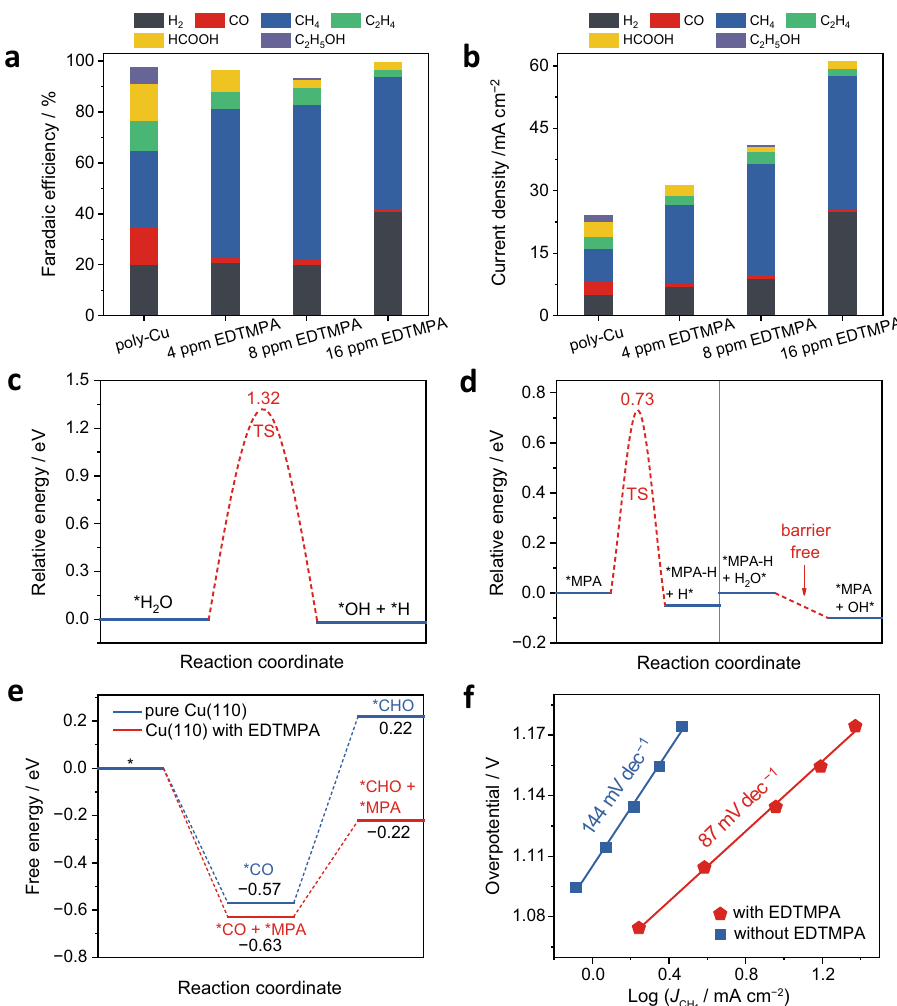
Fig. 4 Proton-feeding ability of EDTMPA. a , b Comparison of the FEs ( a ) and partial current densities ( b ) of various CO 2 RR products at − 1.0 V versus RHE in electrolytes without and with different amounts of EDTMPA (4 ppm, 8 ppm and 16 ppm). c Kinetic energy diagram of water dissociation on bare Cu(110). TS stands for the transition state. d Kinetic energy diagrams of an H atom transferred from MPA to Cu(110) and then an H atom compensated from H 2 O to MPA that loses one H (*MPA − H). e Calculated free energy diagrams of the hydrogenation of *CO species to *CHO species at 0 V (versus the standard hydrogen electrode, SHE) on Cu(110) with and without MPA. f CH 4 Tafel curves in electrolytes with and without